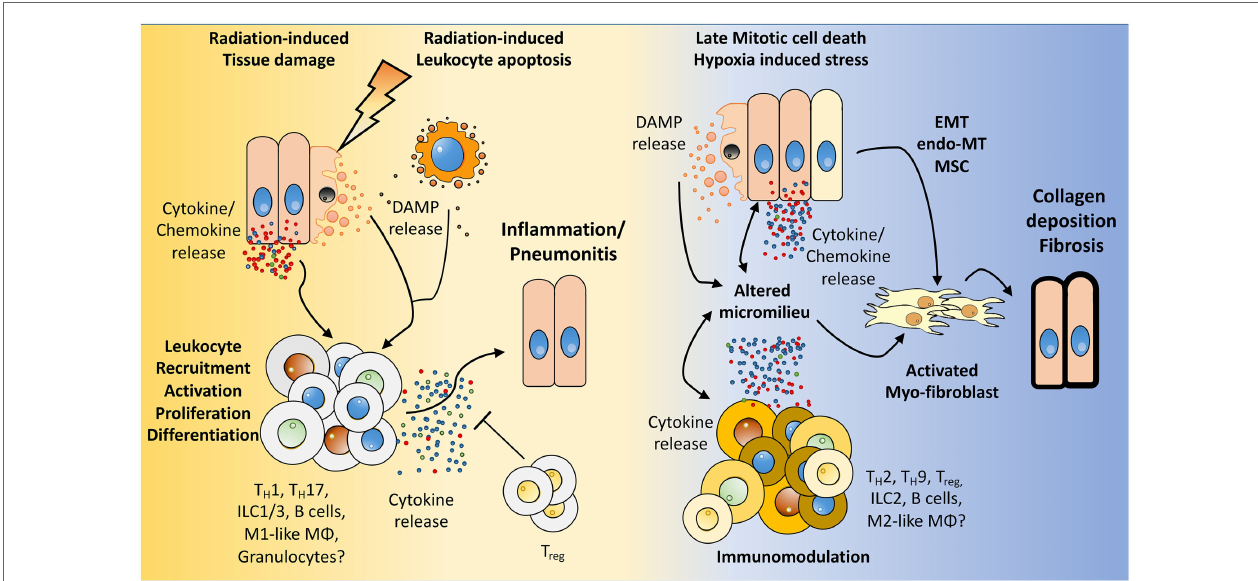
FiGURe 2 | How the microenvironment shapes the immune response and vice versa . We hypothesize that radiation induces damage to tissue resident cells, e.g., endothelial and epithelial lung cells, mesenchymal stem cells (MSC) as well as in resident immune cells. The resulting tissue damage can initiate stress responses or cell death with subsequent release of cytokines/chemokines and damage-associated molecular patterns (DAMPs). This initial damage response leads to the recruitment and activation of diverse immune cells to the lung, among them lymphocytes. Further activation, proliferation of these cells, and secretion of cytokines shape the pulmonary micromilieu toward inflammation and—if this response is too excessive—to the development of severe pneumonitis. Late chronic mitotic cell death and subsequent tissue hypoxia lead to the release of DAMPs and cytokines/chemokines from resident cells thereby altering the micromilieu in the lung. These environmental changes impact on the immune cells present in the lung tissue and promote an altered cytokine release of immune cells. Finally, epithelial- mesenchymal-transition, endothelial-mesenchymal-transition, mesenchymal stem cell differentiation, and the altered environment contribute to the induction of activated myofibroblasts, collagen deposition, and